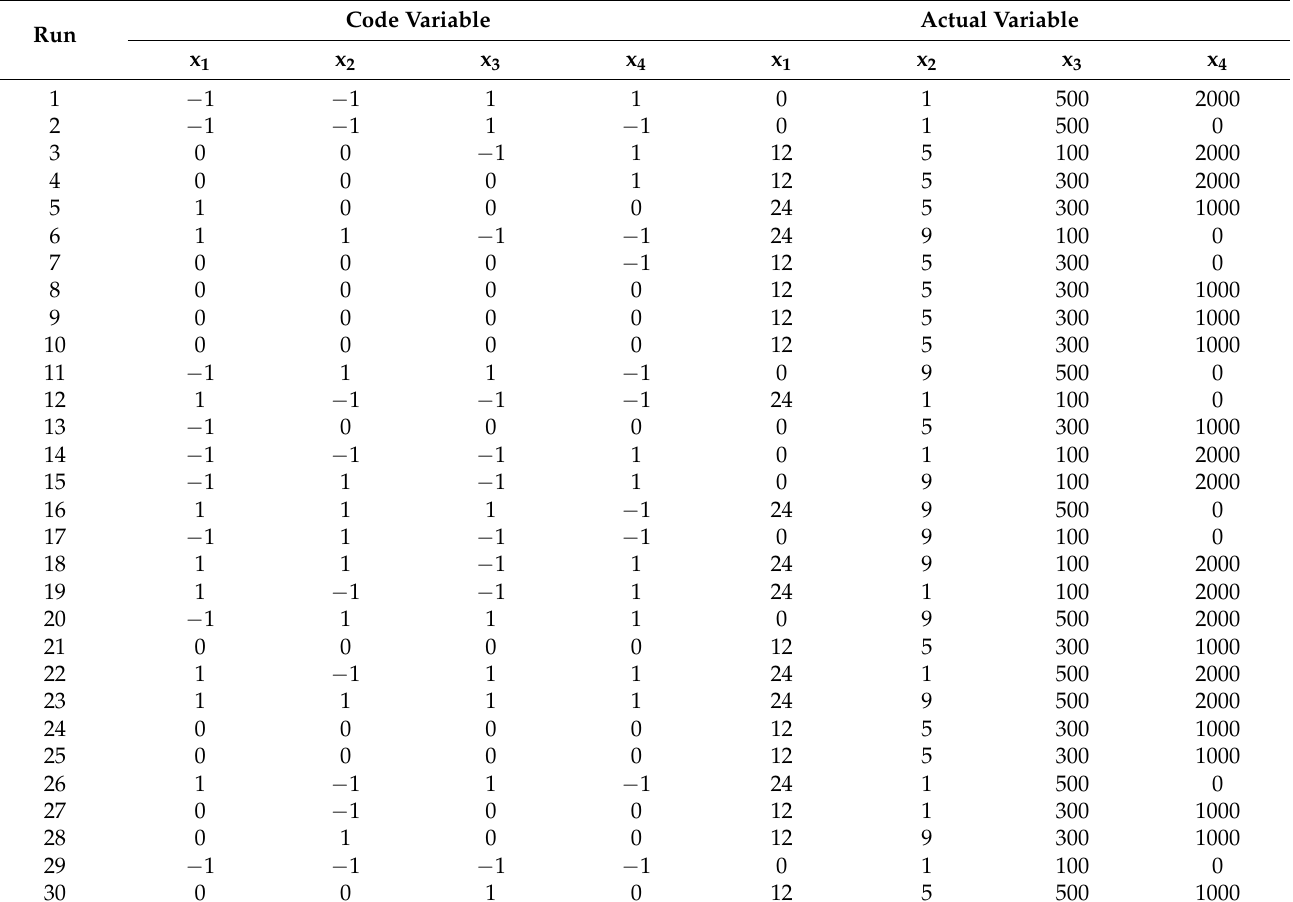
Table 7. Thirty batch experiments of code and actual variable factors related to observed and predicted